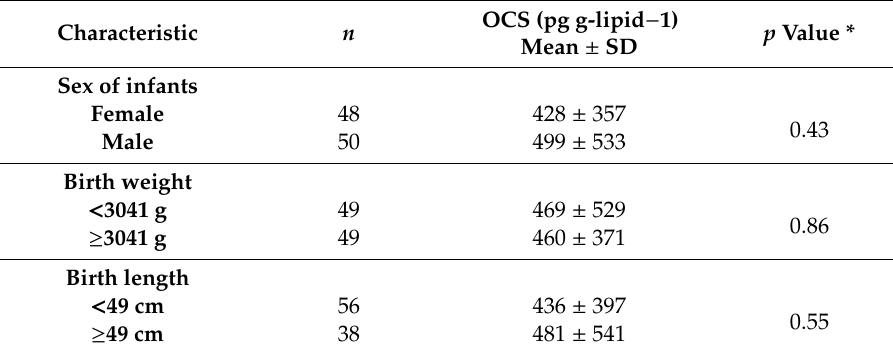
Table 4. Association between OCS and infant